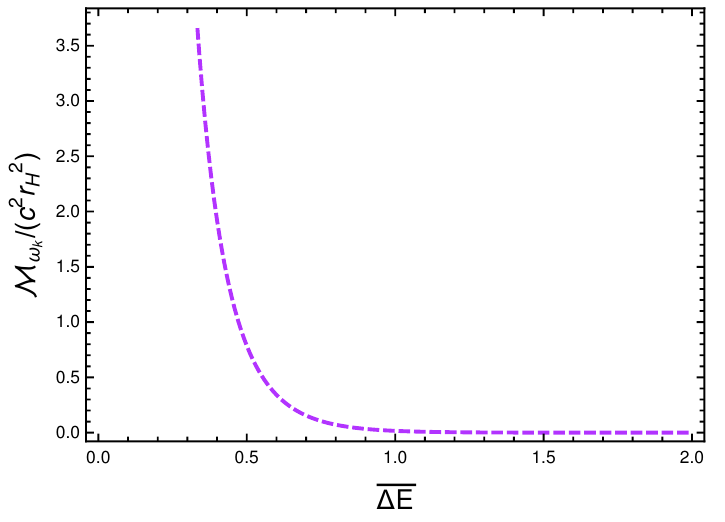
( ρ ) / ( c 2 r 2 ) in (1 + 1) dimensional de Sitter spacetime AB H k = r = 1 , and fixed k H ω k